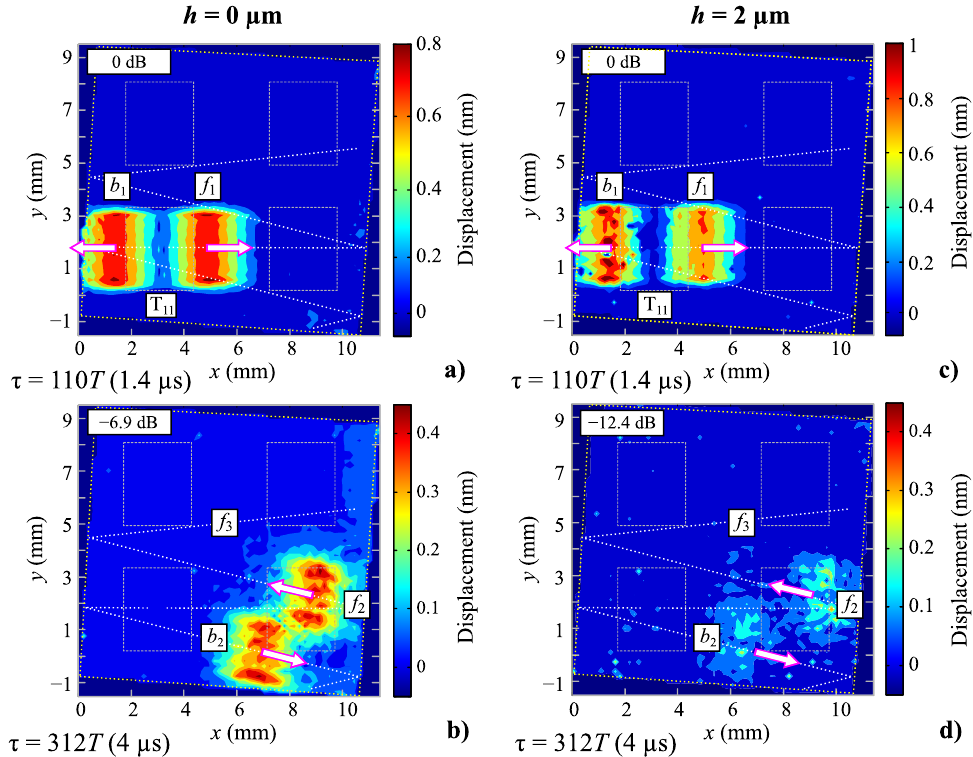
Figure 6. LVD C-scanning of the non-covered ( a , b ) and 2 µm covered ( c , d ) sensors. The same C-scanning was performed for the three sensors coated with